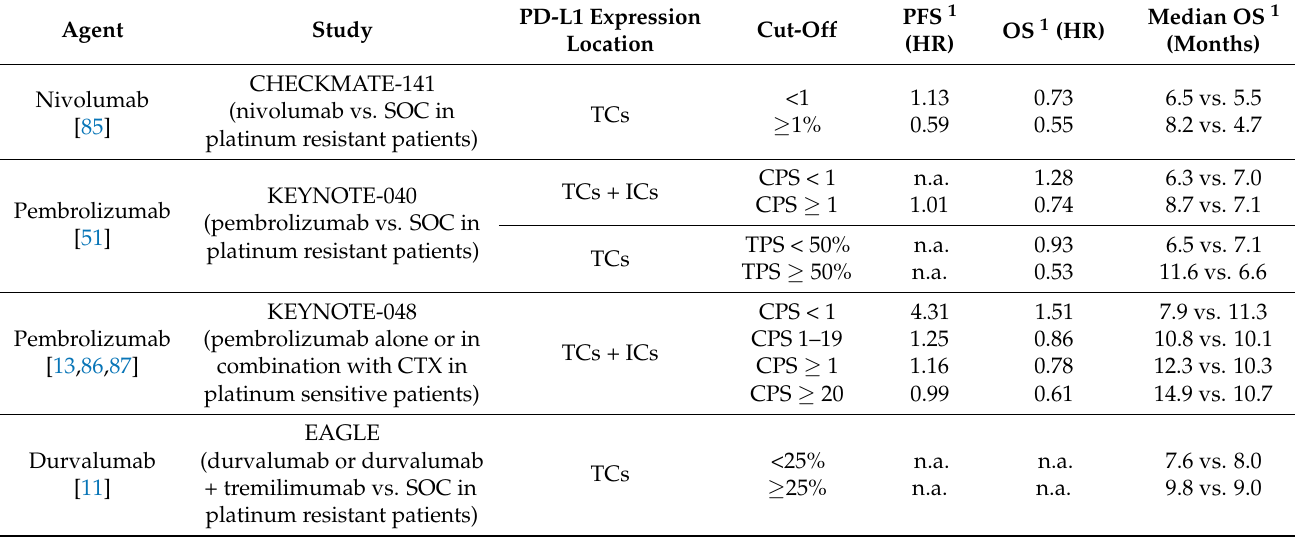
1 Comparison of PFS and OS resulting from nivolumab vs. methotrexate, docetaxel or cetuximab in the CHECKMATE-141 study, pembrolizumab vs. methotrexate, docetaxel or cetuximab in the KEYNOTE-040 study, pembrolizumab vs. platinum, fluorouracil and cetuximab in the KEYNOTE-048 study and durvalumab vs. cetuximab, taxane, methotrexate or fluouracil in the EAGLE trial; PFS = progression free survival, OS = overall survival; HR = hazard ratio; SOC = standard of care; TCs = tumor cells; ICs = immune cells; TPS = tumor proportion score (percentage of tumor cells with membranous PD-L1 expression); CPS = combined positive score (number of PD-L1 positive cells (tumor cells, lymphocytes, and macrophages) out of the total number of tumor cells × 100); n.a. = not available, vs. =